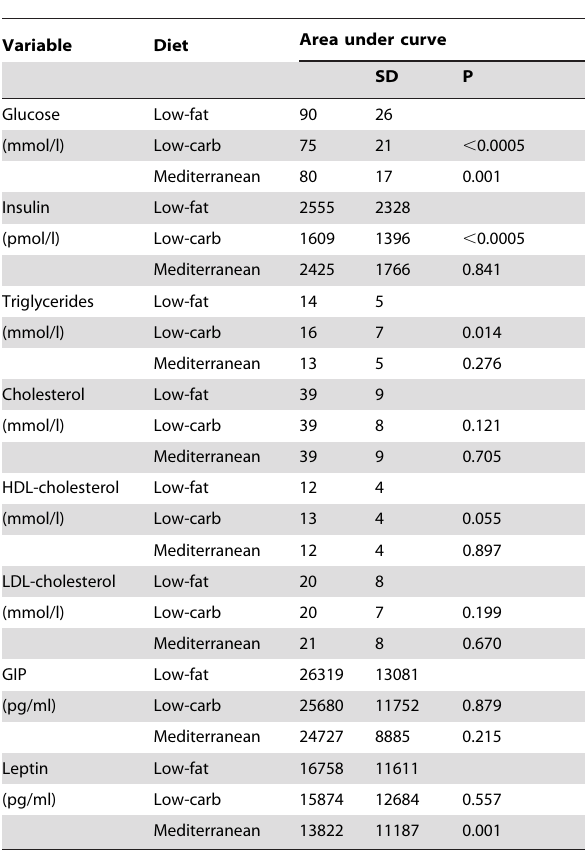
Table 3. Levels of the areas under the curves for the tested variables, standard deviation and the p-value when comparing with the low-fat (control) group at the same time period (Wilcoxon Signed Ranks